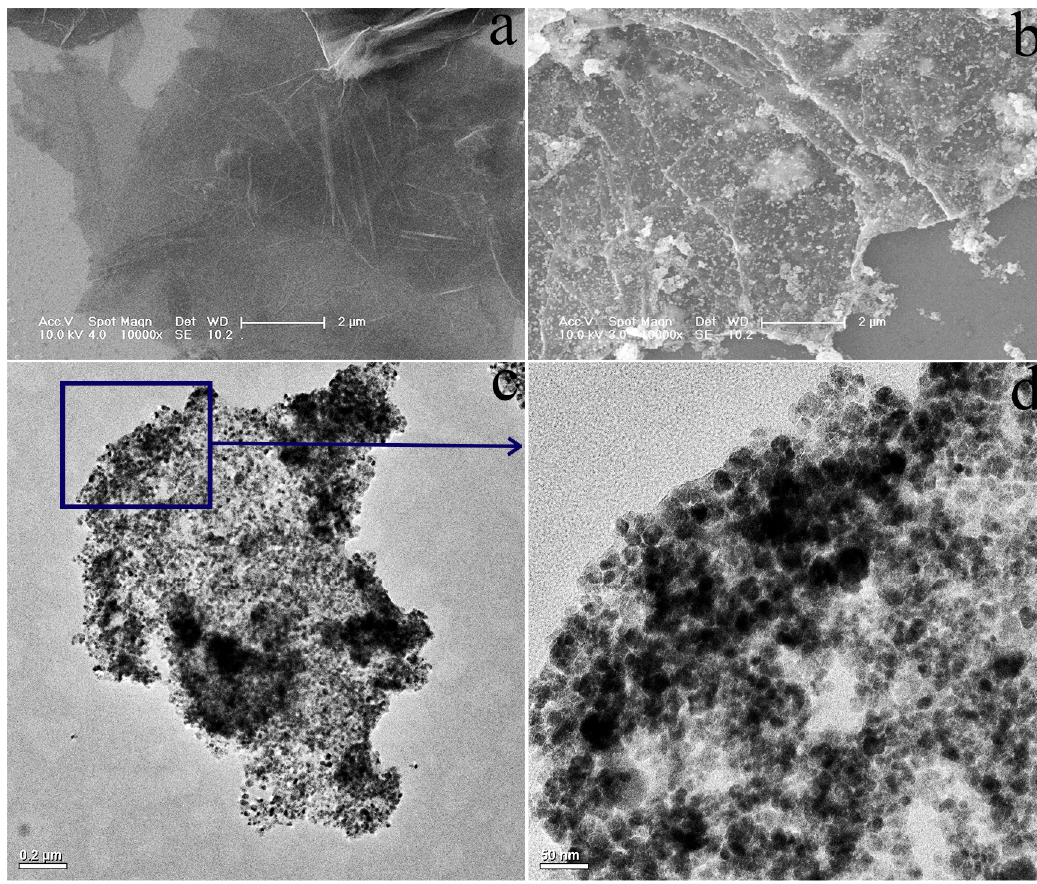
Figure 1. SEM images of ( a ) graphene oxide (GO) and ( b ) magnetic GO (MGO); ( c , d ) TEM images of MGO at different resolutions.